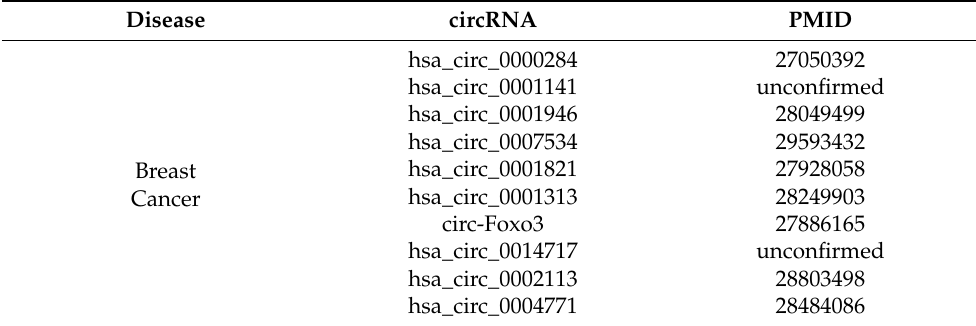
Table 7. The top 10 breast cancer-related candidate circRNAs.